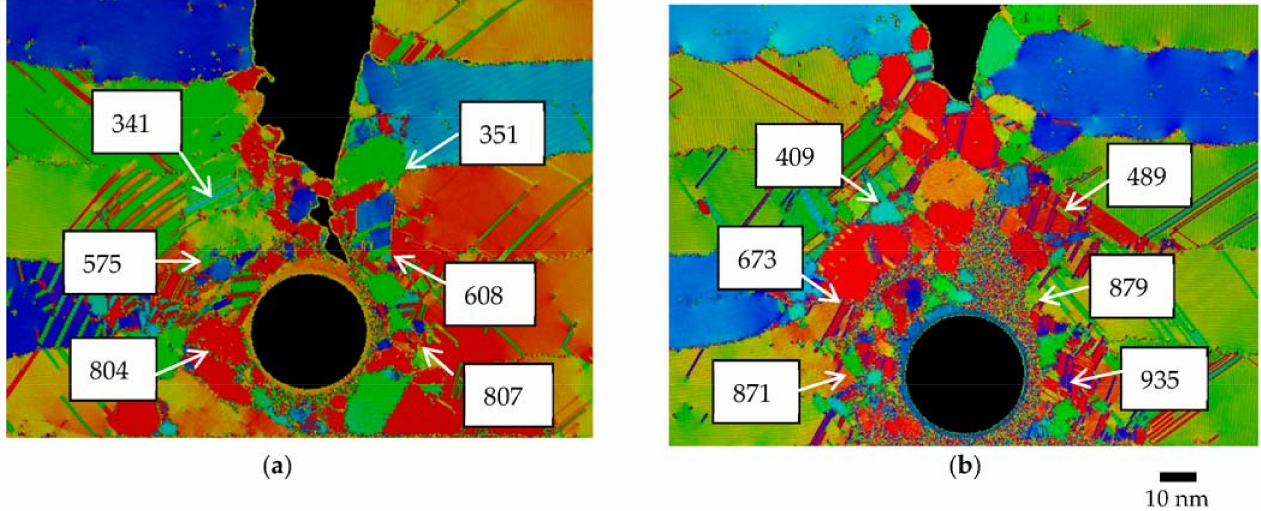
Figure 5. Temperatures (in K) around the pin determined by MD ( a ) at an average temperature of 400 K and ( b ) at an average temperature of 550 K for 1.27 M atoms at 0.01 (ps − 1 )/100 (m/s). The advancing and rotating directions are the same as in Figures